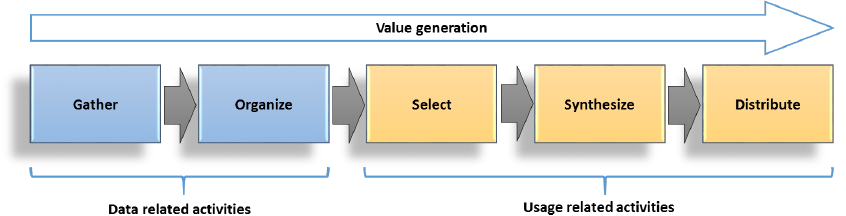
Fig. 5. Virtual value creation process.